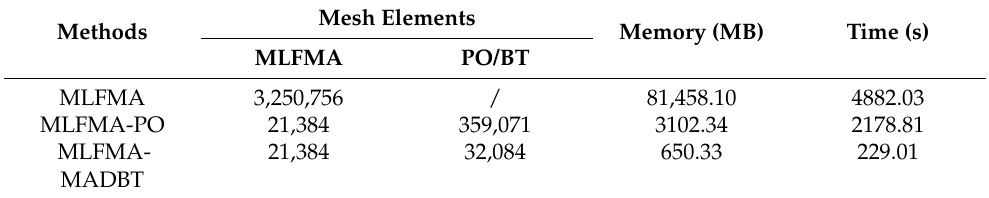
Table 2. Calculation time and memory requirements of different methods for the wire antenna mounted on realistic ship